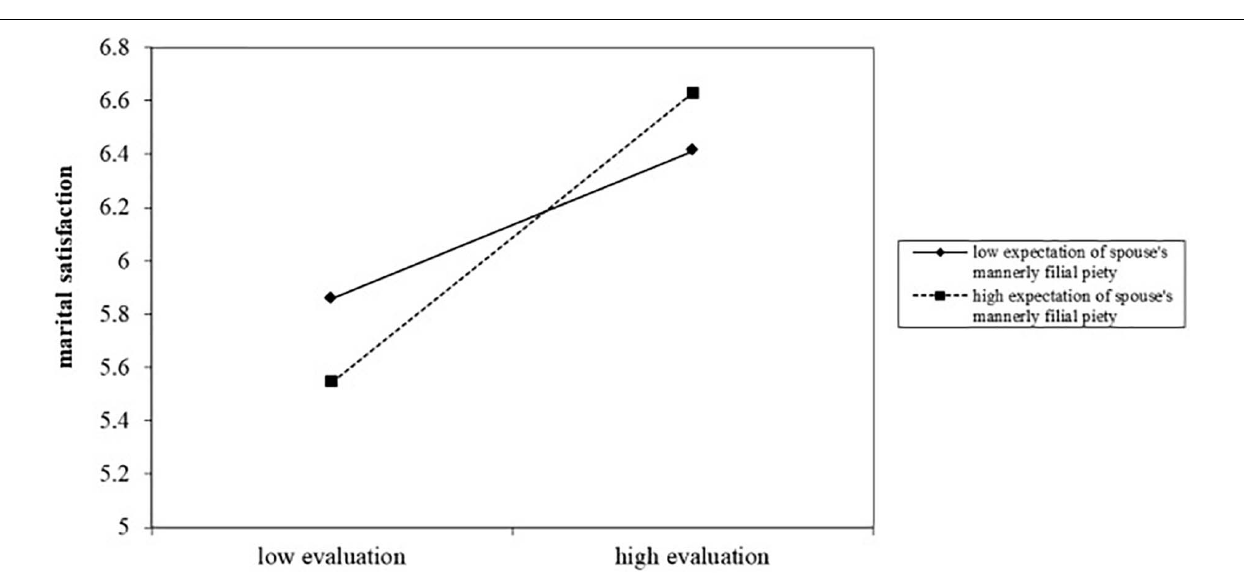
FIGURE 2 | The moderating effect of expectation of mannerly filial piety on the relationship between the corresponding evaluation and marital satisfaction for female